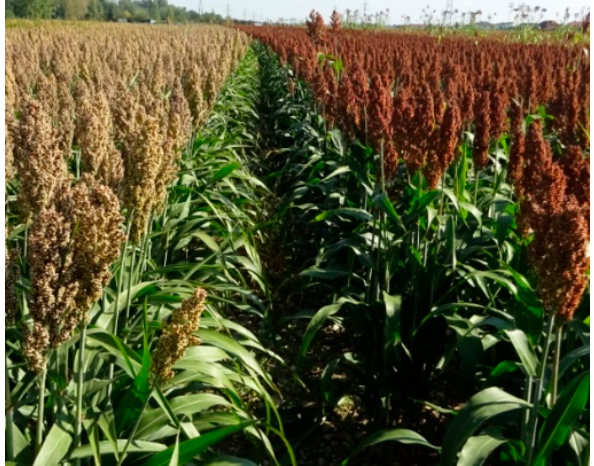
Figure 2. Sorghum field in Hörsching, Austria (©Rumler, 2020). However, the color of the pericarp is not always indicative of the appearance of sor- ghum flour. For example, a sorghum kernel which owns a red pericarp, may have a light endosperm color. Therefore, if special food colors are required, the insertion of sorghum fraction flours may be useful in order to achieve appropriate food appearances [15].